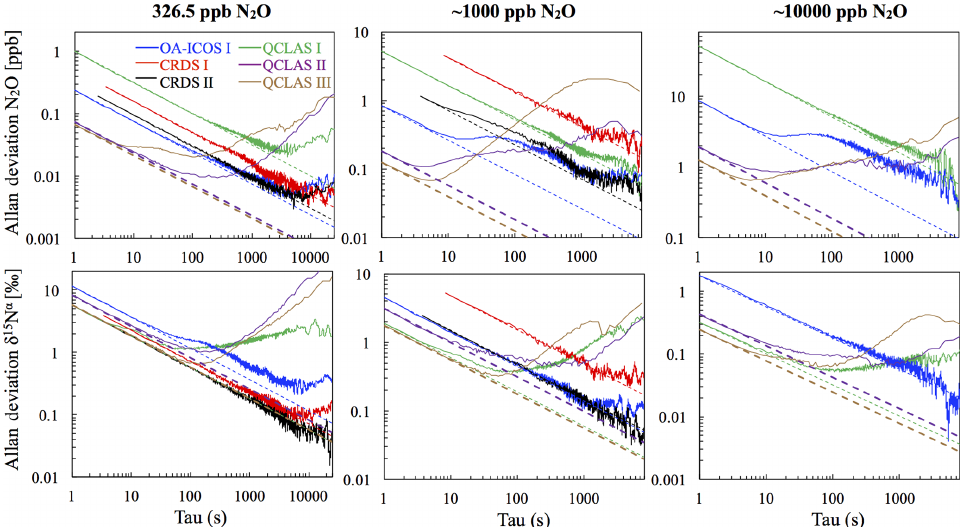
Figure 3. Allan deviation (square root of Allan variance) plots for the OA-ICOS I (blue), CRDS I (red), CRDS II (black), QCLAS I (green), QCLAS II (purple) and QCLAS III (brown) at different N 2 O mole fractions ( ∼ 327, 1000 and 10000ppb). The dashed lines represent a slope of − 0 . 5 (log–log scale) and indicate the expected behavior for Gaussian white noise in each analyzer. The Allan deviations of all analyzers tested were reproducible on three separate occasions prior to the test results presented here. Allan deviation plots for δ 15 N β and δ 18 O are provided in Sect. S4 (Fig. S4-1 in the